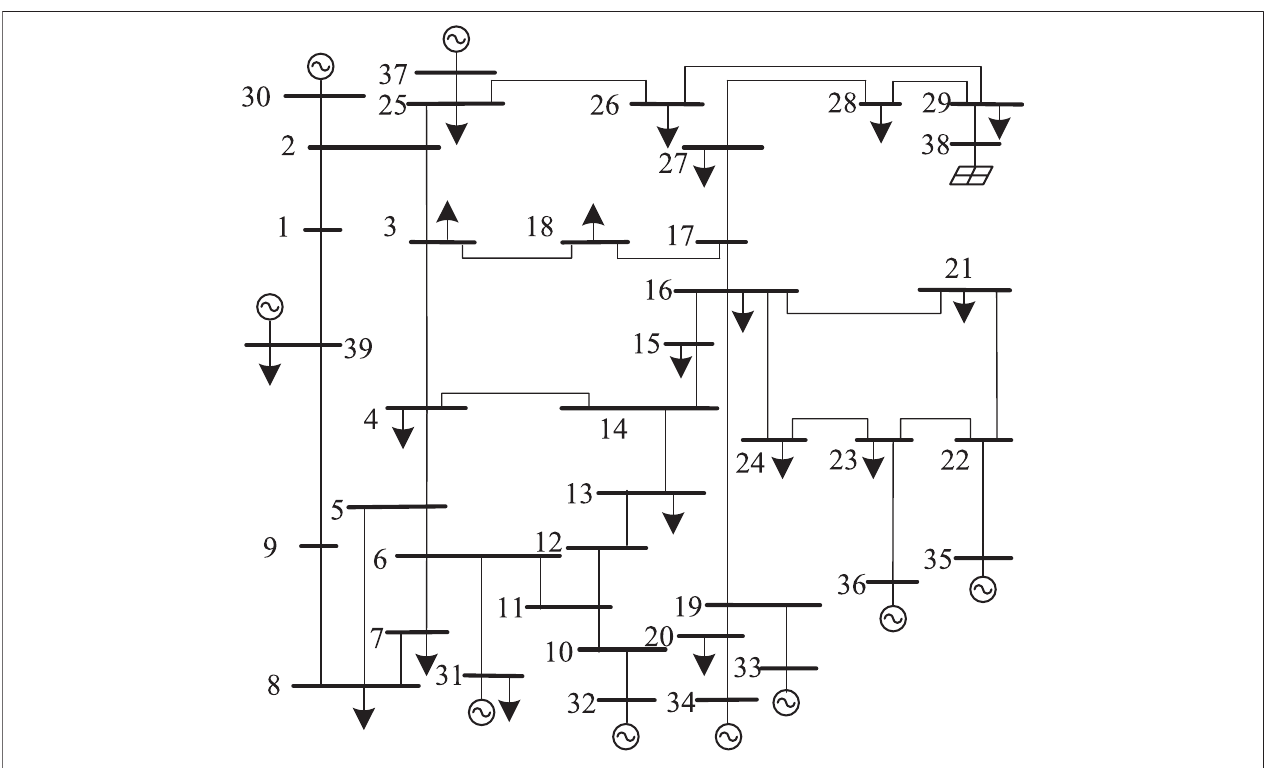
FIGURE 7 | Topology diagram of modi fi ed IEEE 39-bus system.